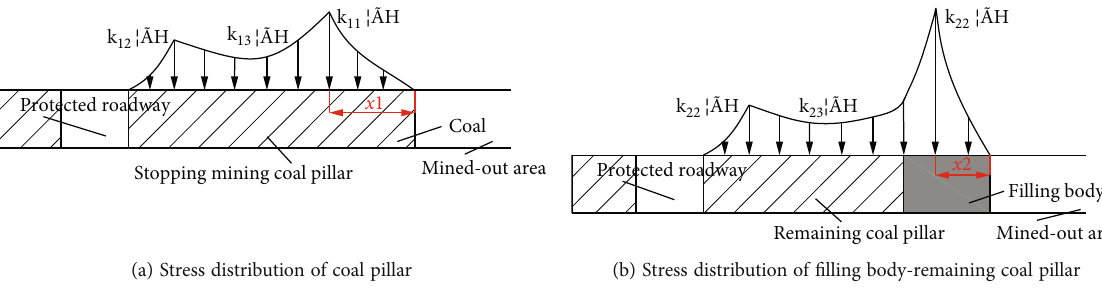
Figure 4: Mechanical model of stopping mining coal